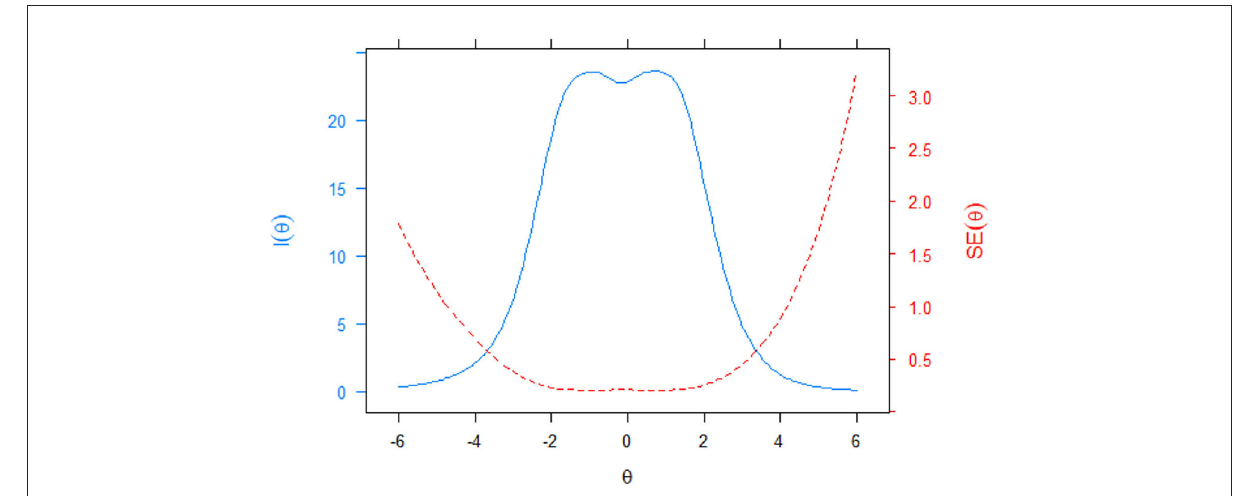
FIGURE3 Test information and standard